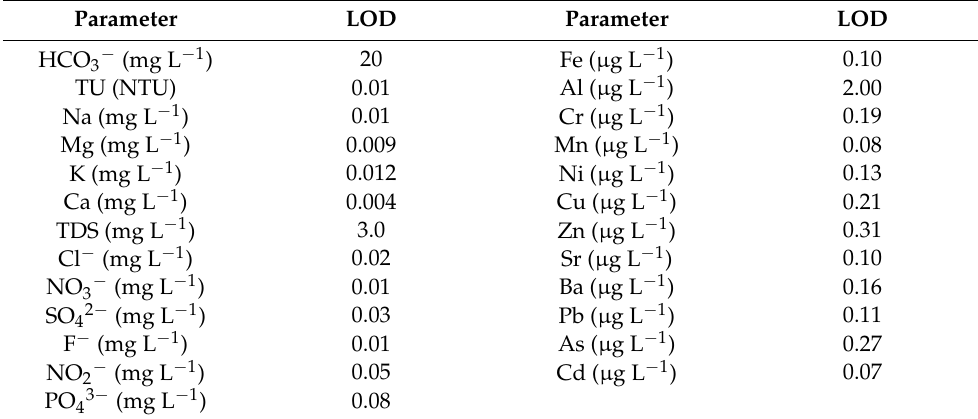
Table 2. The limit of detection (LOD) of the studied parameters in spring